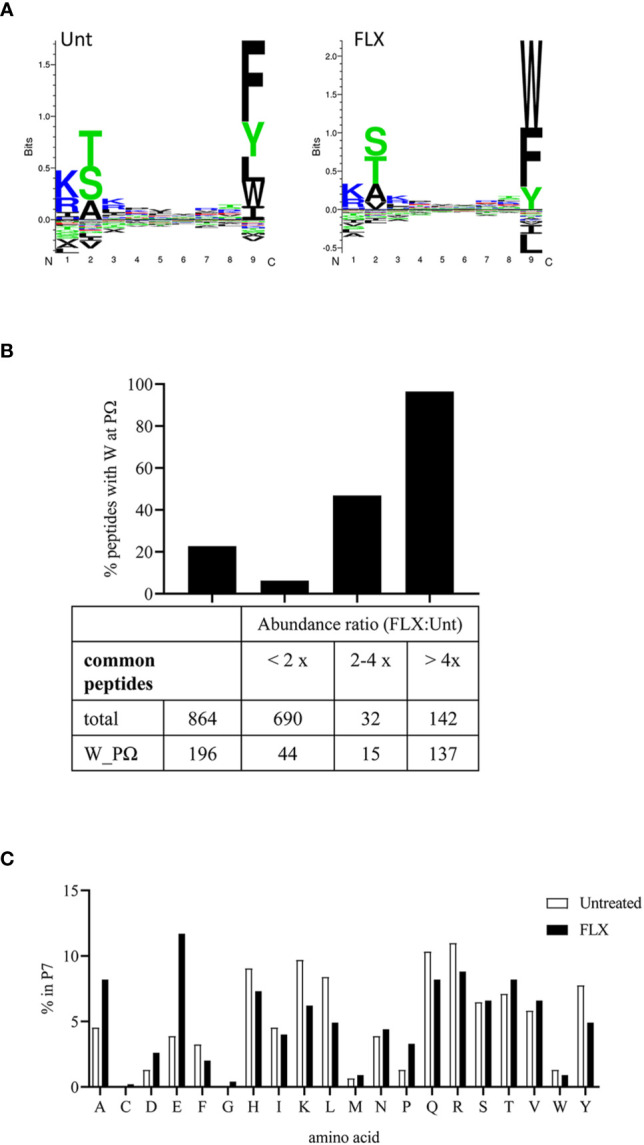
Flucloxacillin (FLX) treatment does not alter consensus peptide binding motif of HLA-B*57:01 peptides but favors peptides with tryptophan in P9/PΩ. (A) Unsupervised analysis of the sequence motif from 9-mer sequences in the immunopeptidome of B721-5701 cells, untreated (Unt) or treated with FLX for 5 days (FLX), using Gibbs Cluster 2.0 software (peptide sequence details provided in Table S2A-B). Peptides with PTMs were excluded from this analysis. (B) Ratio of the abundance of the common peptides in the FLX vs Unt immunopeptidome samples, including total and C-terminal tryptophan (W) peptides. Ratios are represented as FLX : Unt lower than two-fold, between two- and four-fold or higher than four-fold. Abundance values were calculated using Quant analysis of common peptide quantifiable IDs (<1% FDR). (C) Frequency of the different amino acid residues at P7 of 9-mers with predicted binding affinity <50 nM (by NetMHC 4.0 software).